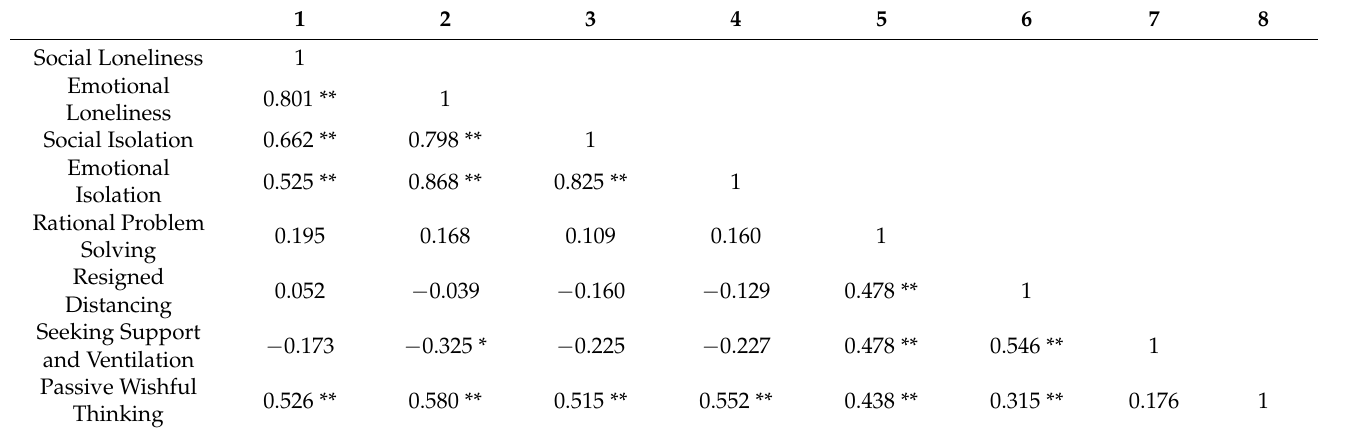
Table 4. Association between coping strategies and social and emotional